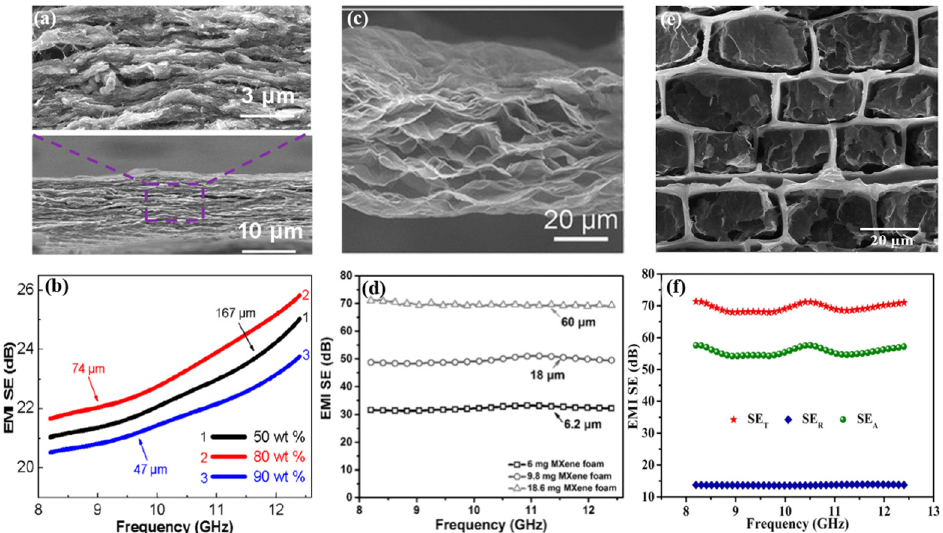
Figure 6. ( a ) SEM images of d-Ti 3 C 2 T x /CNF composite paper with different content of Ti 3 C 2 T x , ( b ) Effect of d-Ti 3 C 2 T x content on the EMI SE of the d-Ti 3 C 2 T x /CNF composite paper sheets with different d-Ti 3 C 2 T x contents and different thicknesses in the X-band region. Reproduced with permission from Cao et al. [102], Binary strengthening and toughening of MXene/cellulose nanofiber composite paper with nacre-inspired structure and superior electromagnetic interference shielding properties; published by American Chemical Society, 2018. ( c ) SEMs image of MXene foam, ( d ) EMI SE of the MXene foams with different thicknesses. Reproduced with permission from Liu et al. [11], Hydrophobic, flexible, and lightweight MXene foams for high-performance electromagnetic-interference shielding; published by John Wiley & Sons, 2017. ( e ) SEMs image of MXene aerogel/WPC composites, ( f ) EMI SE of MXene aerogel/WPC composites. Reproduced with permission from Liang et al. [103], Ultra-light MXene aerogel/wood-derived porous carbon composites with wall-like “mortar/brick” structures for electromagnetic interference shielding; published by Elsevier, 2020.